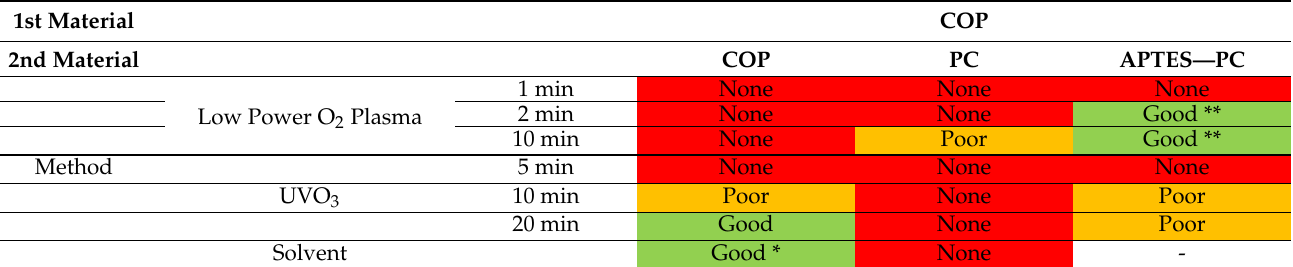
Table 1. Direct polymer bonding results for COP. (*) low optical quality; (**) Good results only on one side of the membrane, unable to obtain a proper polymer-PC membrane-polymer sandwich; (-) not tested. 1st